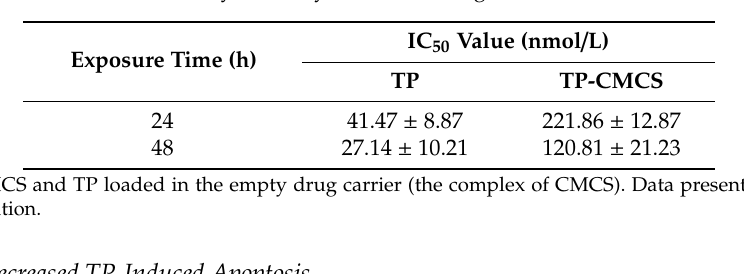
Figure 2. The in vitro cytotoxicity of free TP or TP-CMCS on RAW264.7 cells. The concentrations of TP were 6.875, 13.75, 27.5, 55, 111, 222, 444, and 888 nM, respectively ( A ) and the concentrations of TP-CMCS were equal to TP concentration ( B ). Logx represents the logarithm of the drug concentration. *** Represented p < 0.001, vs. TP groups. Table 1. In vitro cytotoxicity of TP-CMCS against RAW264.7cells